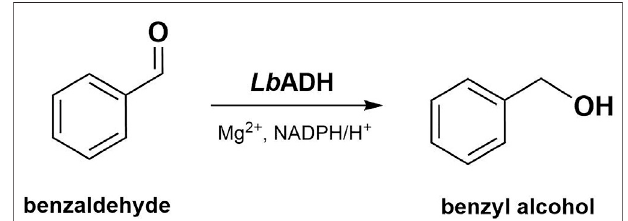
FIGURE 9 | Schematic conversion of benzaldehyde to benzyl alcohol catalyzed by the Lb ADH involving NADPH and Mg 2+ .